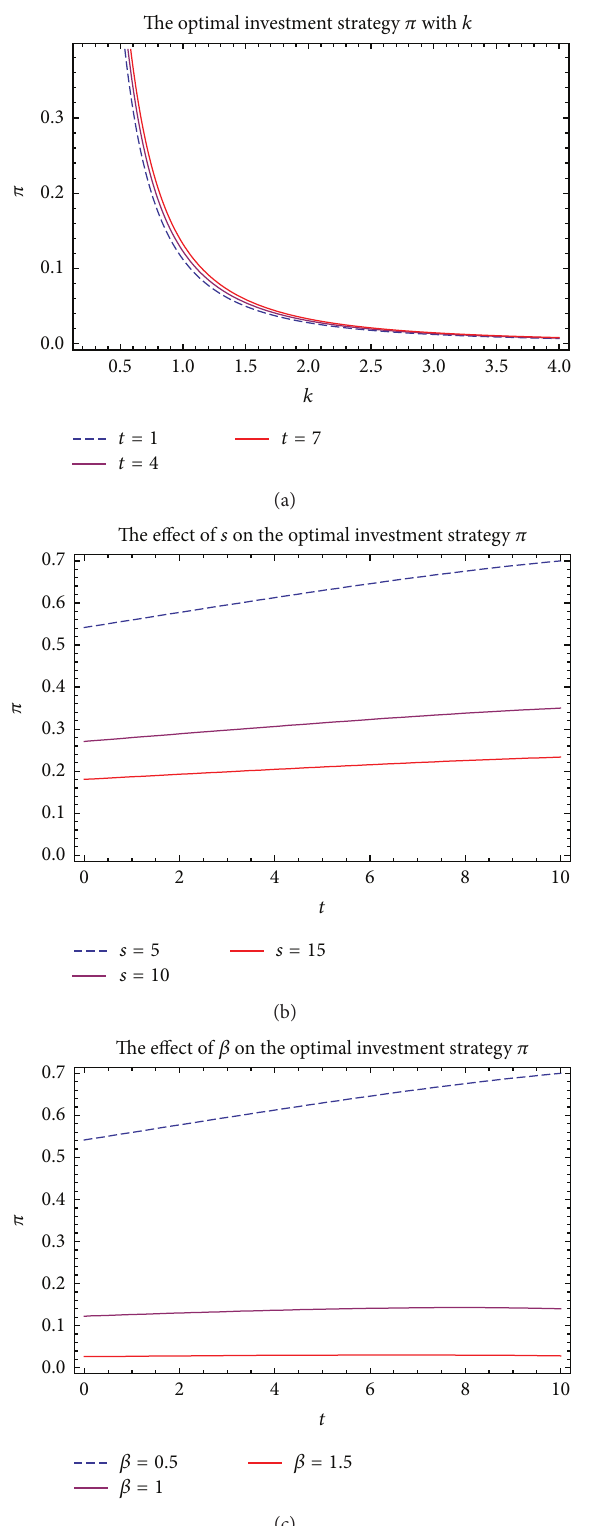
Figure 3: (a) The optimal investment strategy decreases with respect to 𝑘 . (b) The optimal investment strategy 𝜋 decreases with respect to 𝑠 . (c) The optimal investment strategy 𝜋 decreases with respect to 𝛽